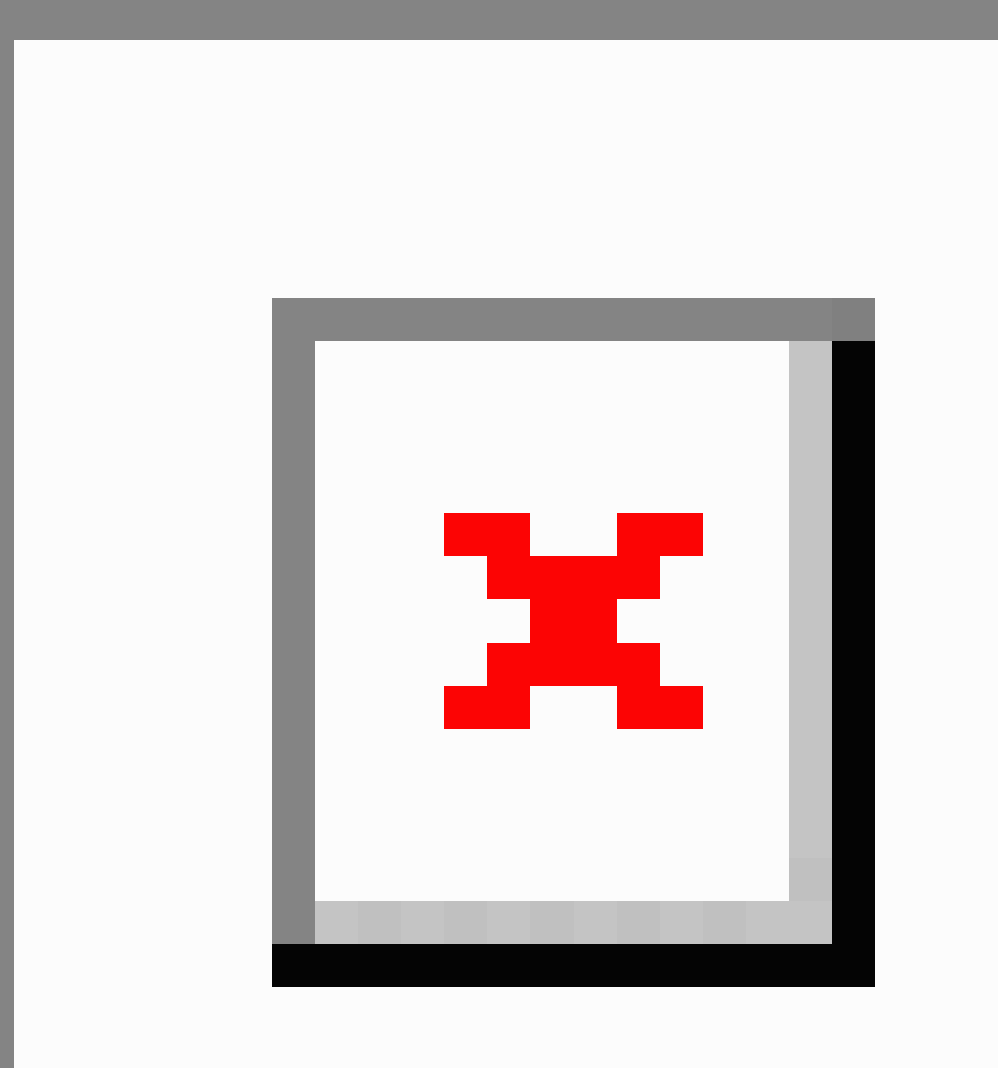
Figure 1. Proportion of depression respondents within each age group reporting confidence using individual